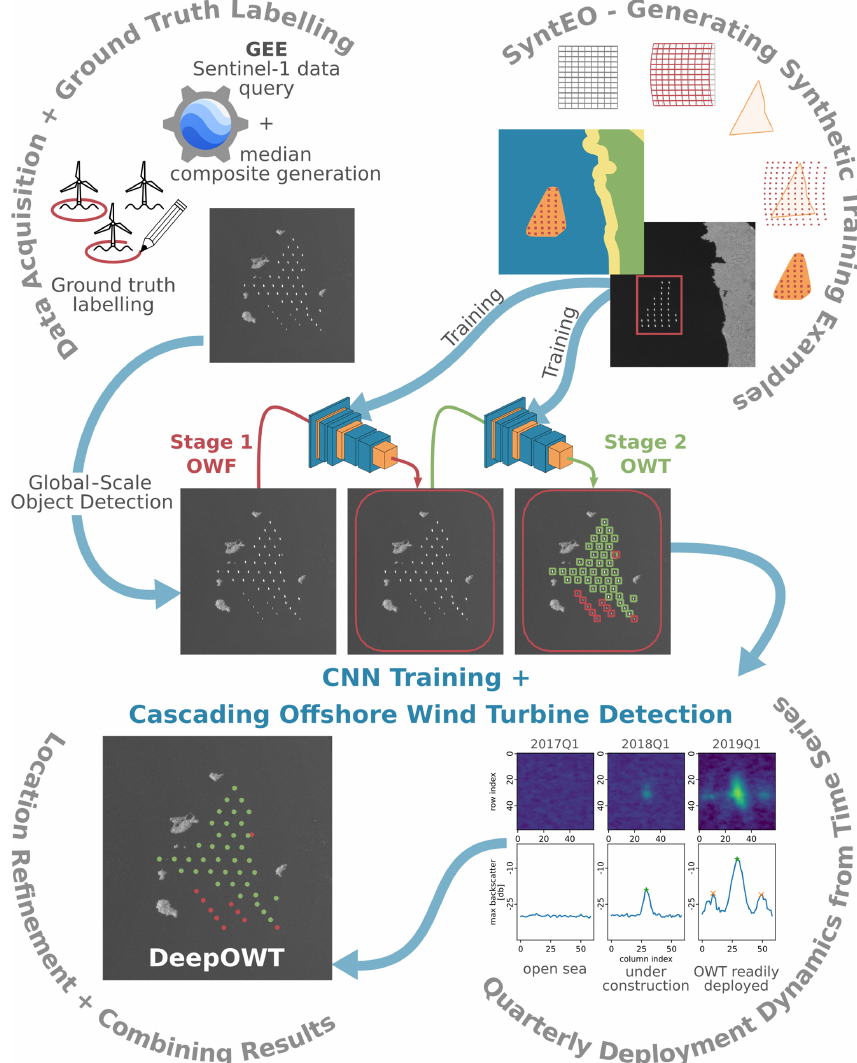
Figure 2. The methodological workflow used to generate the DeepOWT data set based on the Sentinel-1 archive. Two CNNs detect OWF and OWT locations, trained on synthetic examples. These spatial detections are used to define their temporal dynamics and an accurate location. Finally, DeepOWT combines these spatiotemporal